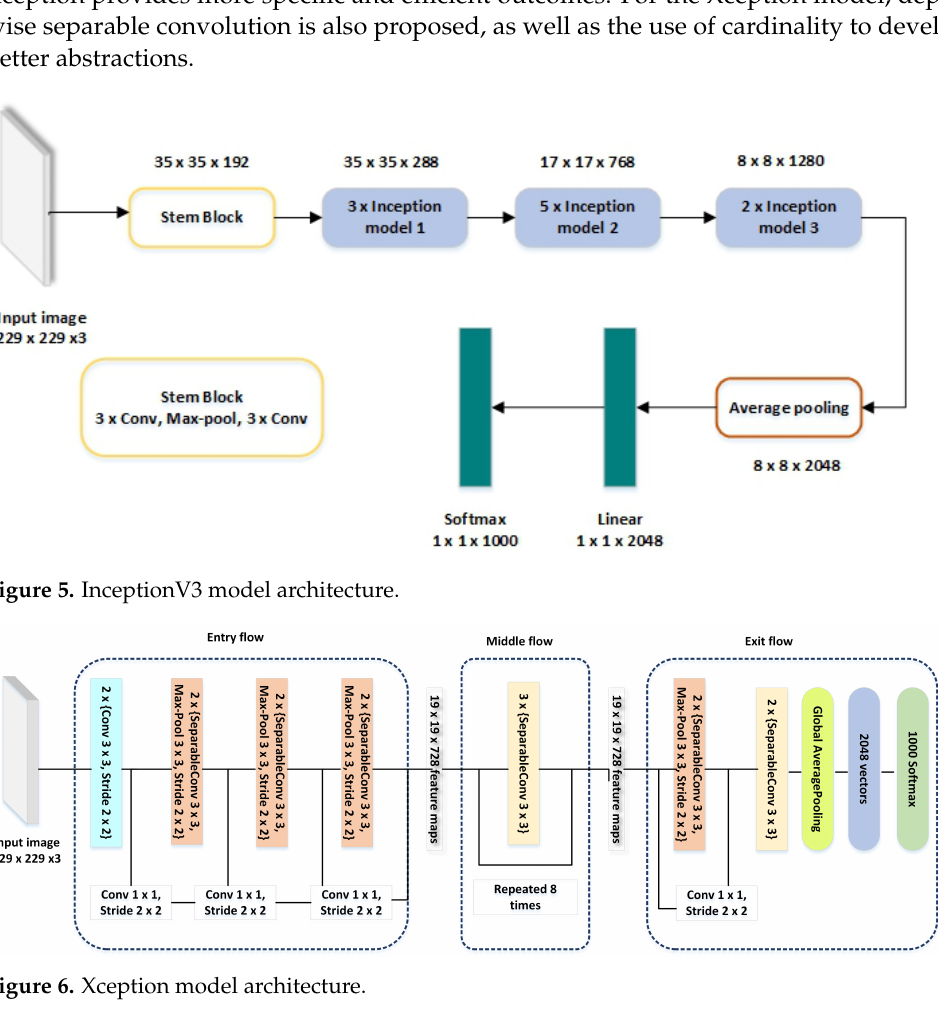
Figure 6. Xception model